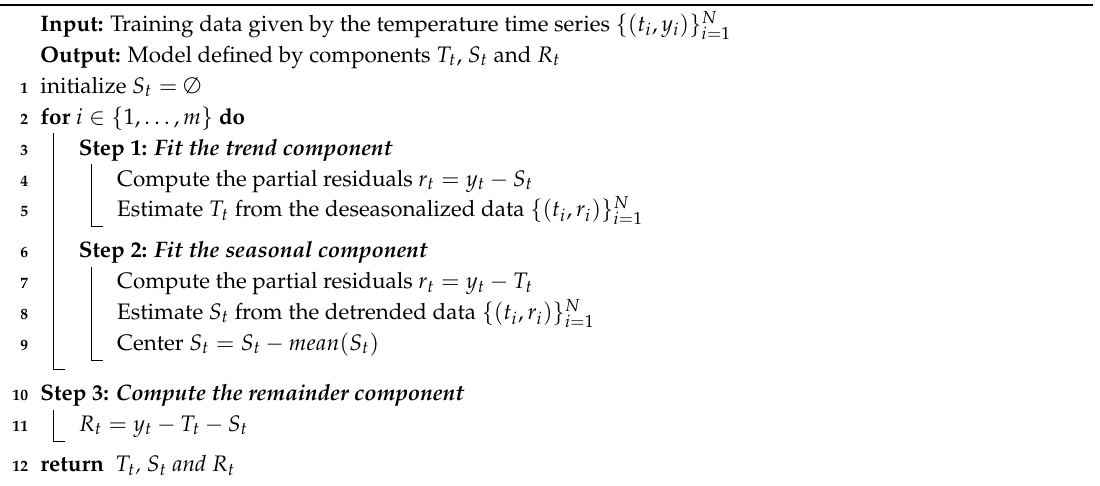
Algorithm 1: The backfitting algorithm for the additive decomposition